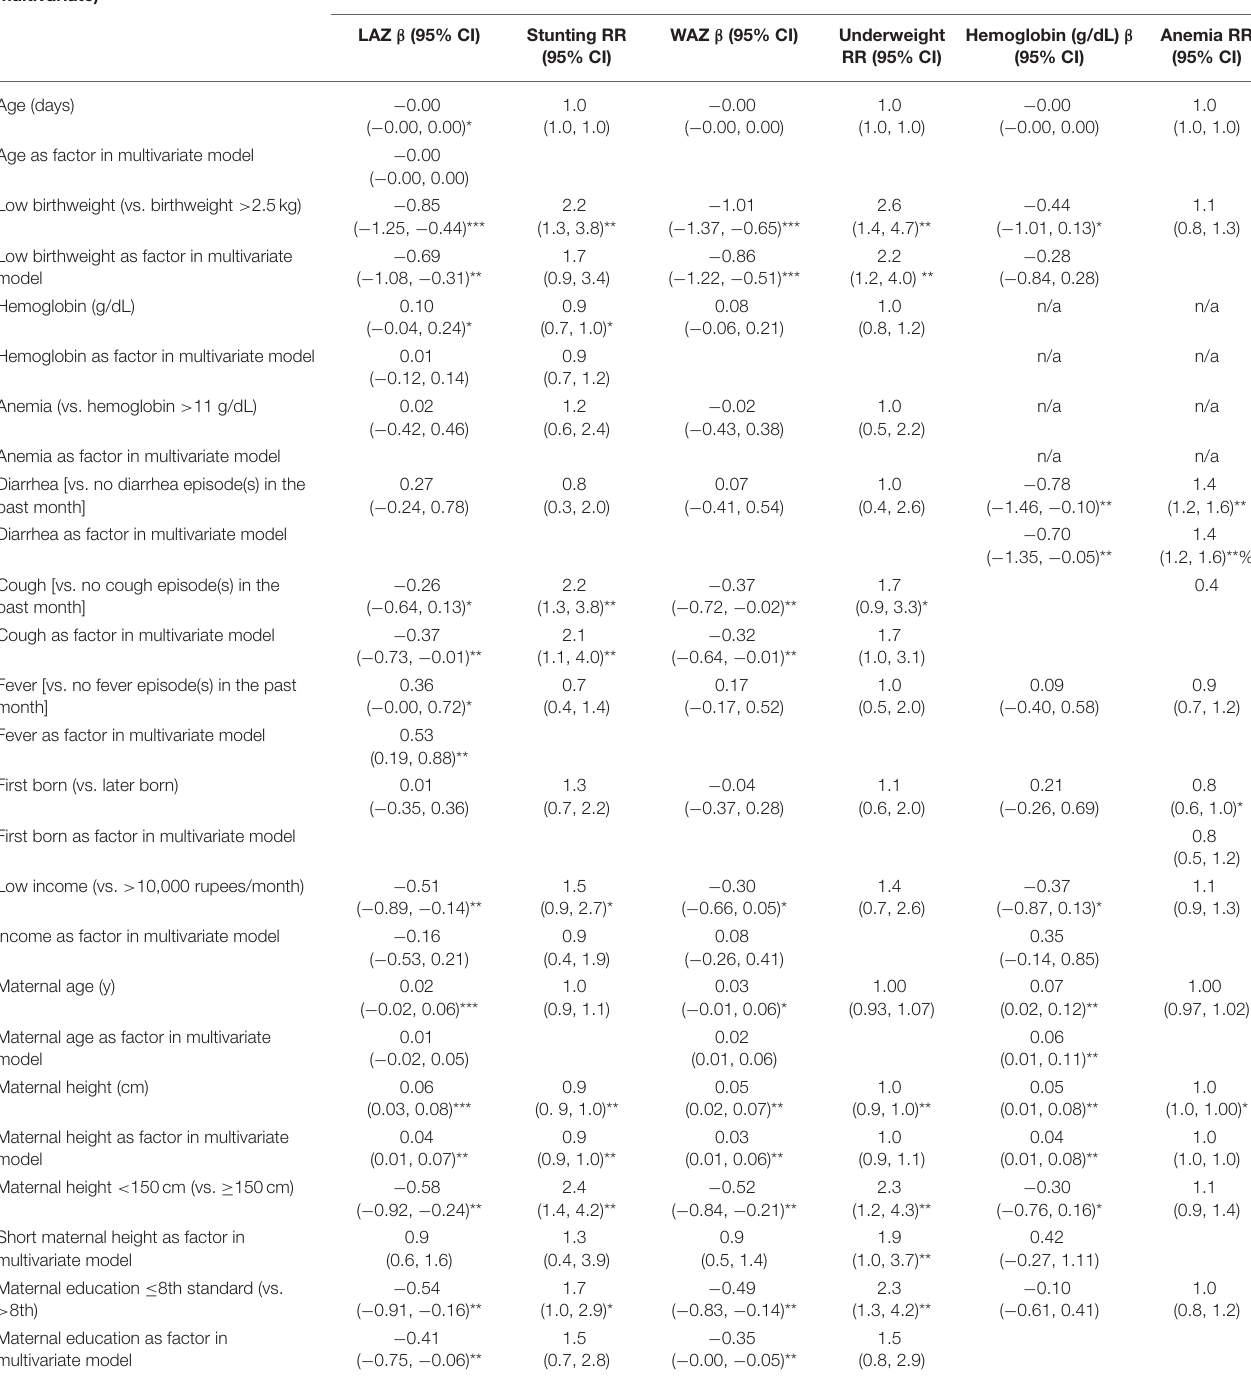
TABLE 4 | Correlates of poor growth and anemia among n = 159 female children. Correlate (univariate,